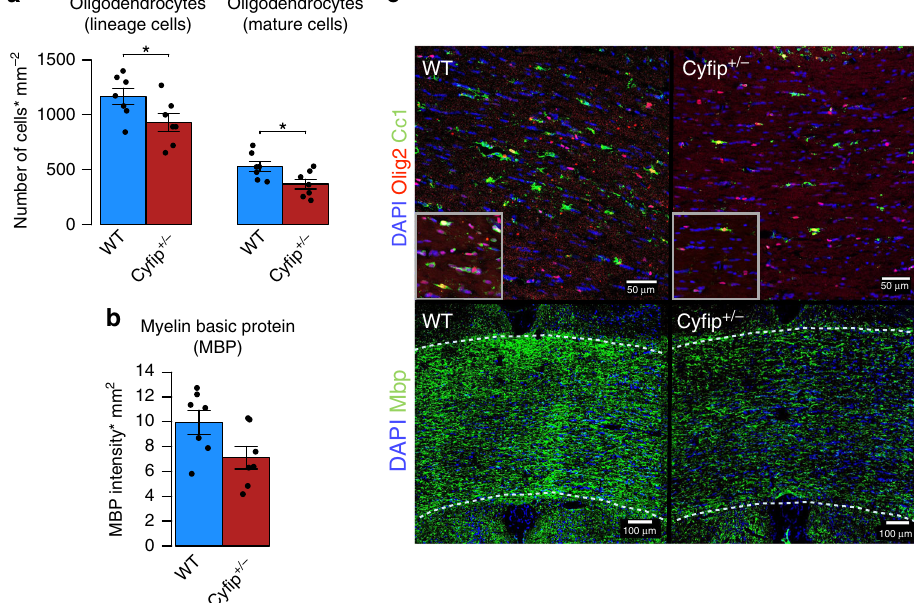
Fig. 3 Altered number of oligodendrocyte lineage and mature cells, and levels of myelin basic protein (MBP), in the corpus callosum of the Cy fi p1 + / − rats. a Mean number of oligodendrocyte lineage ( n = 7 each; t = 2.18, df = 11.94, *), stained with Olig2, and mature ( n = 7 each; t = 2.48, df = 11.99, *), stained with Olig2 and Cc1, cells per mm2. b Mean MBP intensity multiplied by the percentage area (mm 2 ) of the staining ( n = 7 each; t = 2.16, df = 11.96, p = 0.052). c Representative images (at magni fi cation ×20 (top) and ×10 (bottom)) for the following immunomarkers: DAPI, Olig2, Cc1 and Mbp in the corpus callosum of the WT and Cy fi p1 + / − rats. Scale bars = 50 μ m (top) and 100 μ m (bottom). Differences between groups were assessed using a two-tailed unpaired t -test. Data are mean ± SEM; *<0.05, **<0.01, ***<0.001. Source data are provided as a Source Data fi